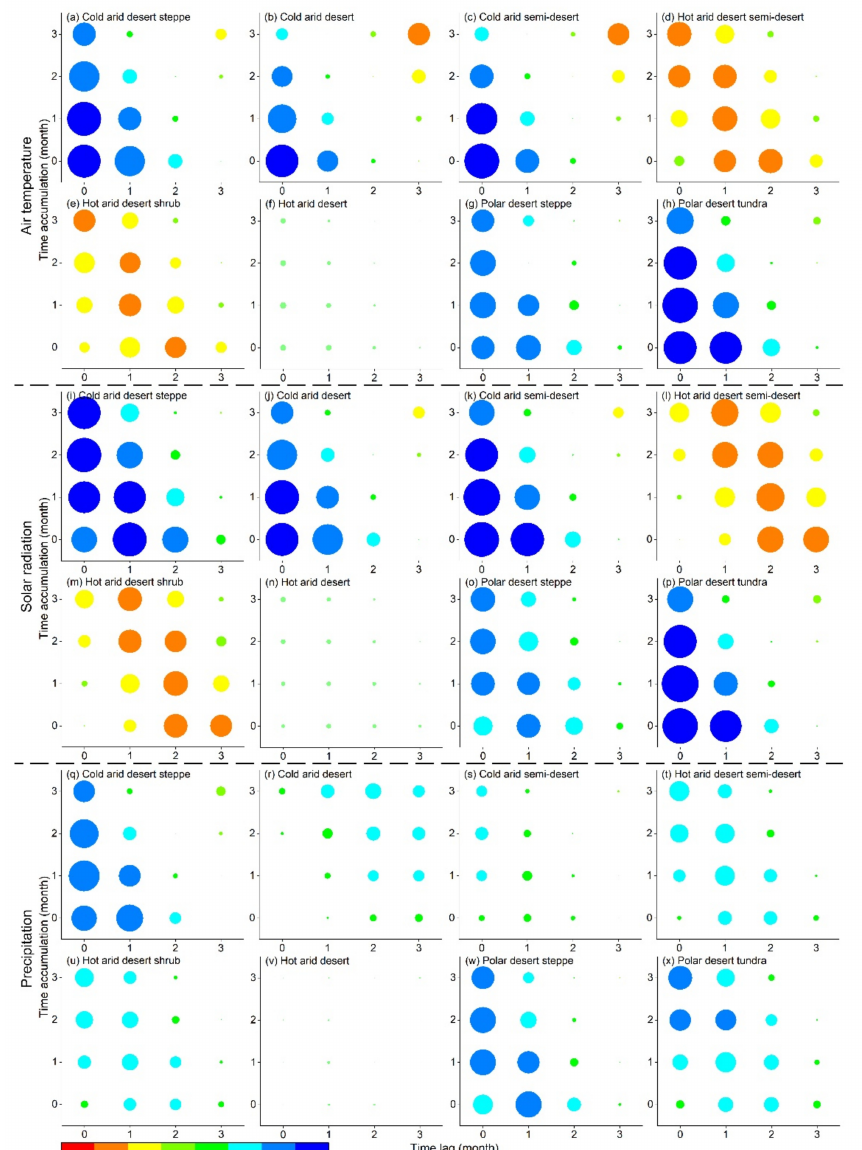
Figure 6. Coefficient of determination in simple linear regression models between the NDVI and each climatic factor considering the time-lag and time-accumulation effect in different desert areas. ( a – x ) indicate different desert areas with the time effects of air temperature, solar radiation, and precipitation,